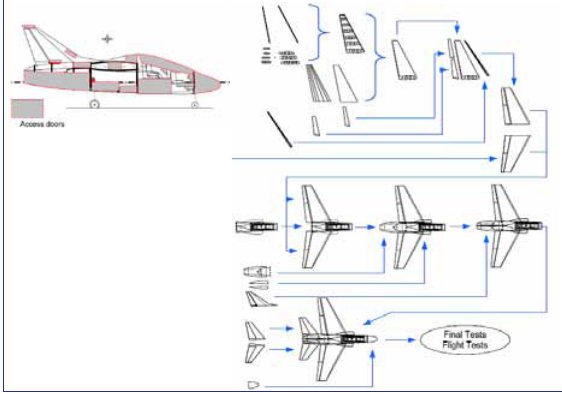
Fig. 14. System installation preliminary study Fig. 15. Accessibility studies and first hypothesis about assembly